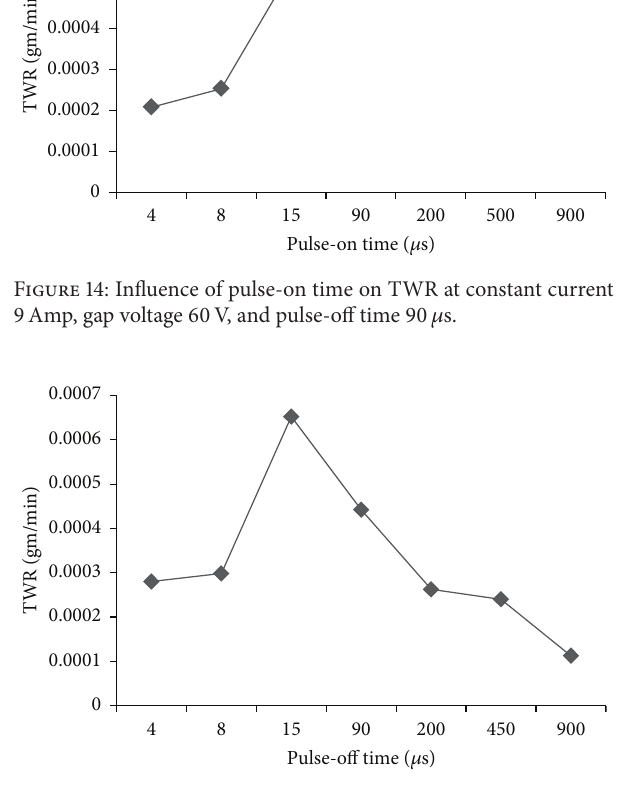
better results of surface finish are